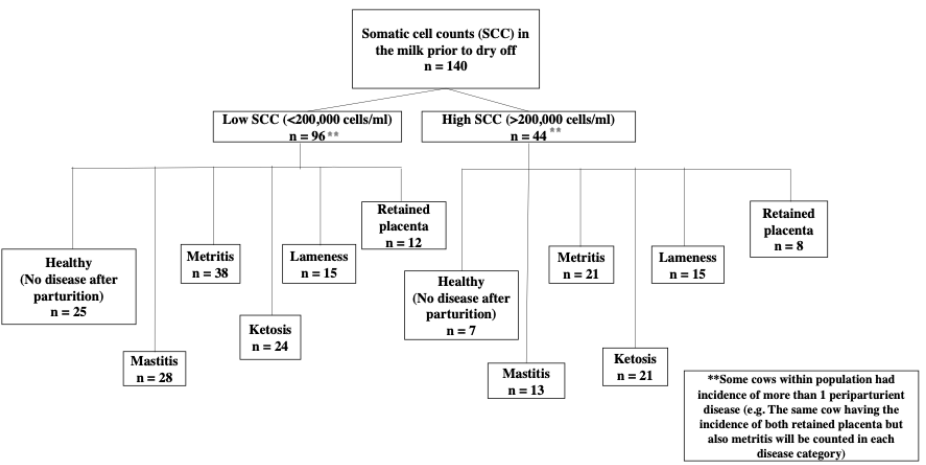
Figure 1. Flow diagram for the incidence rate of diseases for cows grouped based on somatic cell counts (SCC) in the milk obtained at prior to dry off (approximately 1 week before the expected date of dry off). Cows with SCC < 200,000 cells/mL were sorted into the Low SCC group, and cows with SCC > 200,000 cells/mL were sorted into the High SCC group. After parturition, cows from each group were evaluated for each of the five diseases of interest (i.e., mastitis, metritis, ketosis, lameness, and retained placenta) with the total number of cows per each disease indicated in each box in the diagram. Healthy cows were identified if no incidence of disease